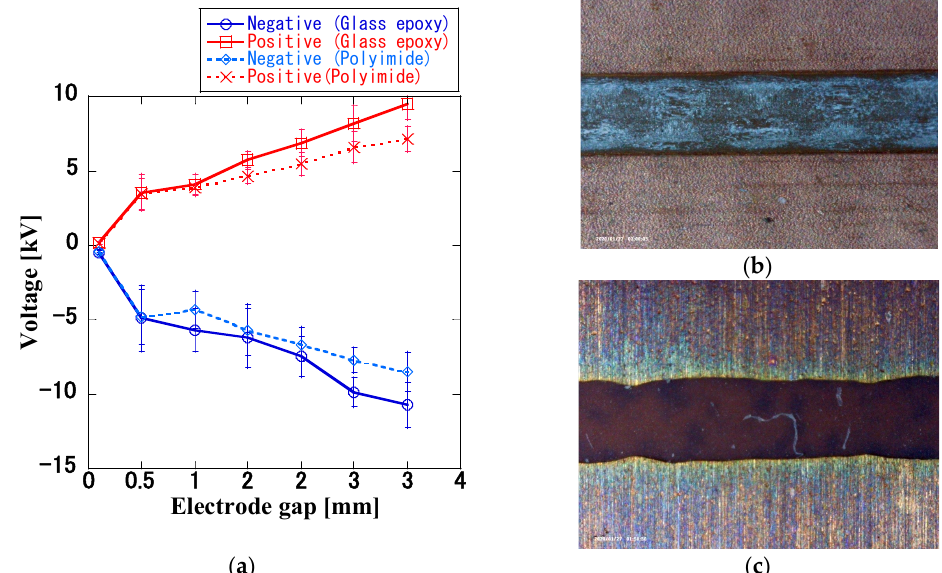
Figure 3. Discharge voltage variation and enlarged view of the electrodes for each material. ( a ) The discharge voltage of electrodes using glass epoxy and polyimide as insulators was observed. It was found that the discharge voltage increased in proportion to the distance between the electrodes for both insulating materials. It was also found that the negative discharge voltage was greater than the positive discharge voltage, with the voltage being higher when glass epoxy was used as the insulating material. The error bars in the data indicate the standard deviations. The upper figure shows a ( b ) glass epoxy material ( c ) polyimide material. The glass epoxy had smooth electrodes, while protrusions were observed on the electrode surfaces of the polyimide substrates.